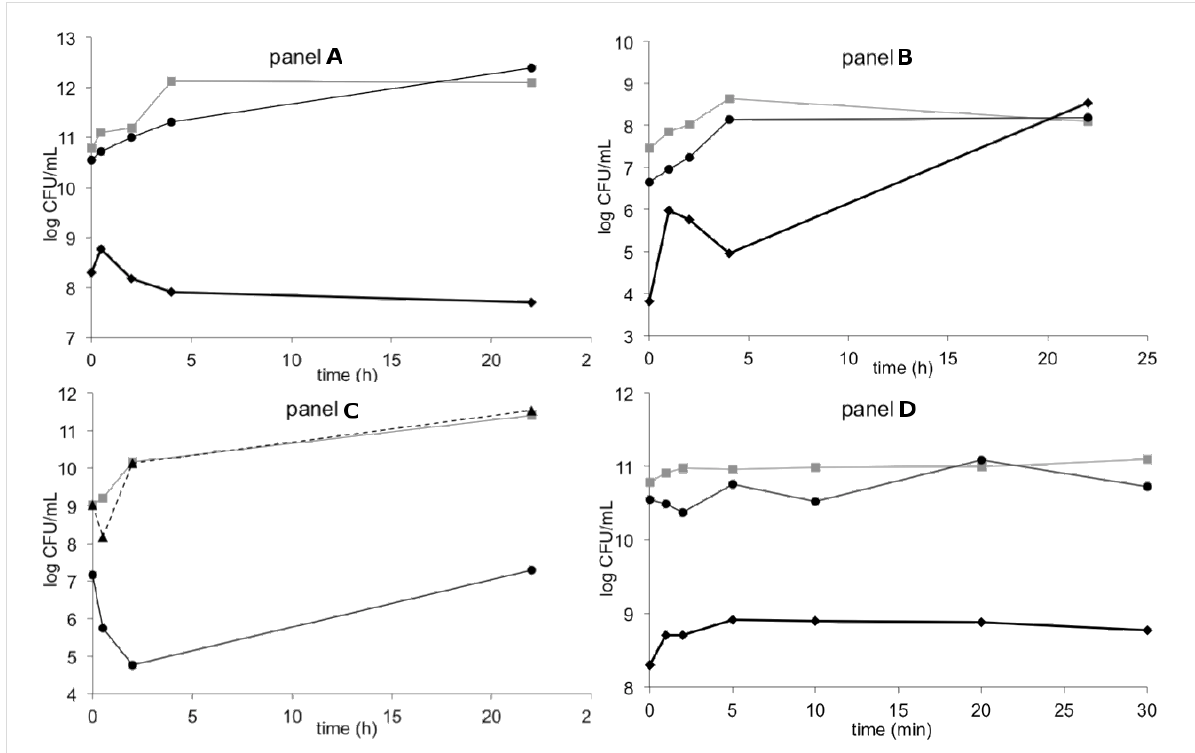
Figure 2: Bactericidal activity of (RW) 3 against S. aureus 133 (panel A and D ) or B. megaterium (panel B ) and of RcCO-W(RW) 2 (panel C ) against S. aureus 133. Panel D shows the experiment on S. aureus 133 (as in panel A ) using short-term intervals for sample collection (note that the time-scale is given in minutes). The first points in each graph are obtained after 1 min. Concentrations are denoted by: grey squares (for the control), black triangles with dotted line (only in panel C , 0.5 × MIC: 1.0 µg/mL for RcCO-W(RW) 2 ), black circles with narrow line (1 × MIC: 0.8 µg/mL for (RW) 3 and 1.9 µg/mL for RcCO-W(RW) 2 ), black diamonds with thick line (5 × MIC: 4 µg/mL for (RW) 3 , only in panels A , B , and D ).